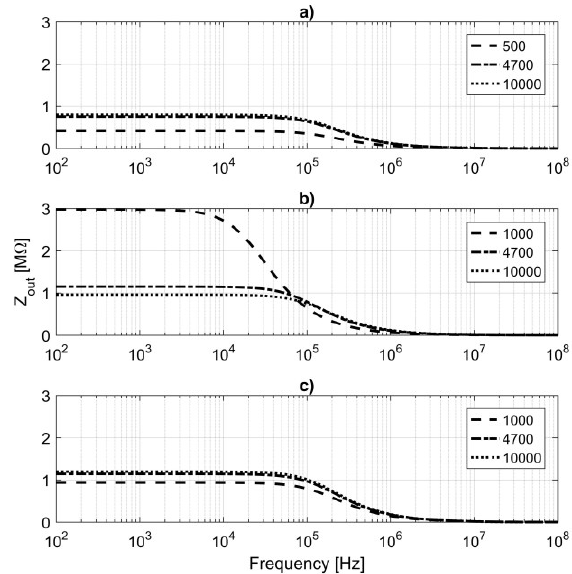
Fig.11: Simulated output impedance when the value of R 3 is changed. The value of R 3 in ohms is showed at the legends. a) QUAD b) DIF_C c) DIF_M.